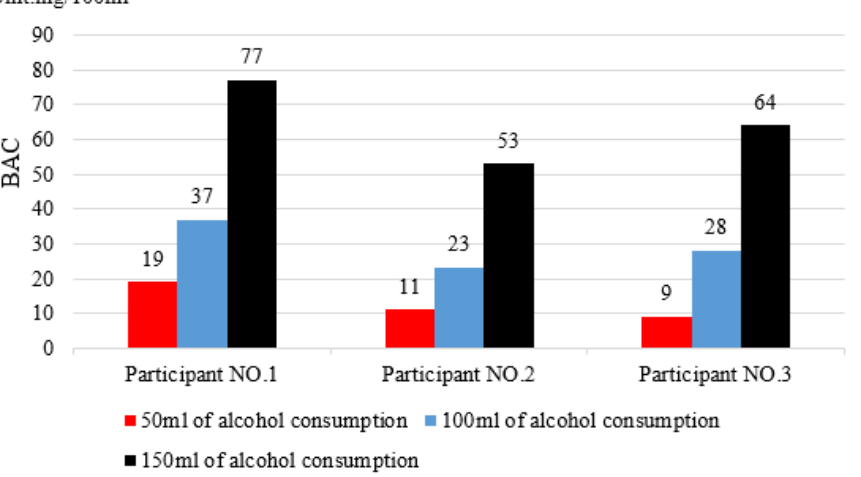
Figure 6. An illustration of the histograms of BAC (blood alcohol concentration) test data after one hour of drinking in subjects who consumed varying amounts of alcohol.